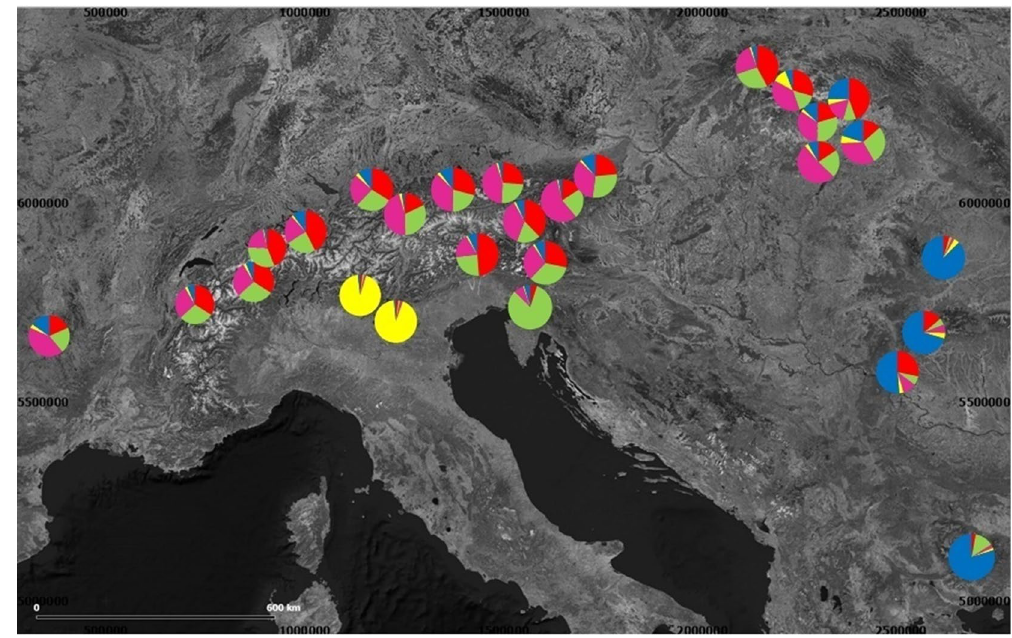
Figure 4. Cluster analysis with STRU CTU RE for K = 5 based on allozyme polymorphism. The colors indicate the distinct genetic clusters to which the individuals of a population are assigned. The map was created